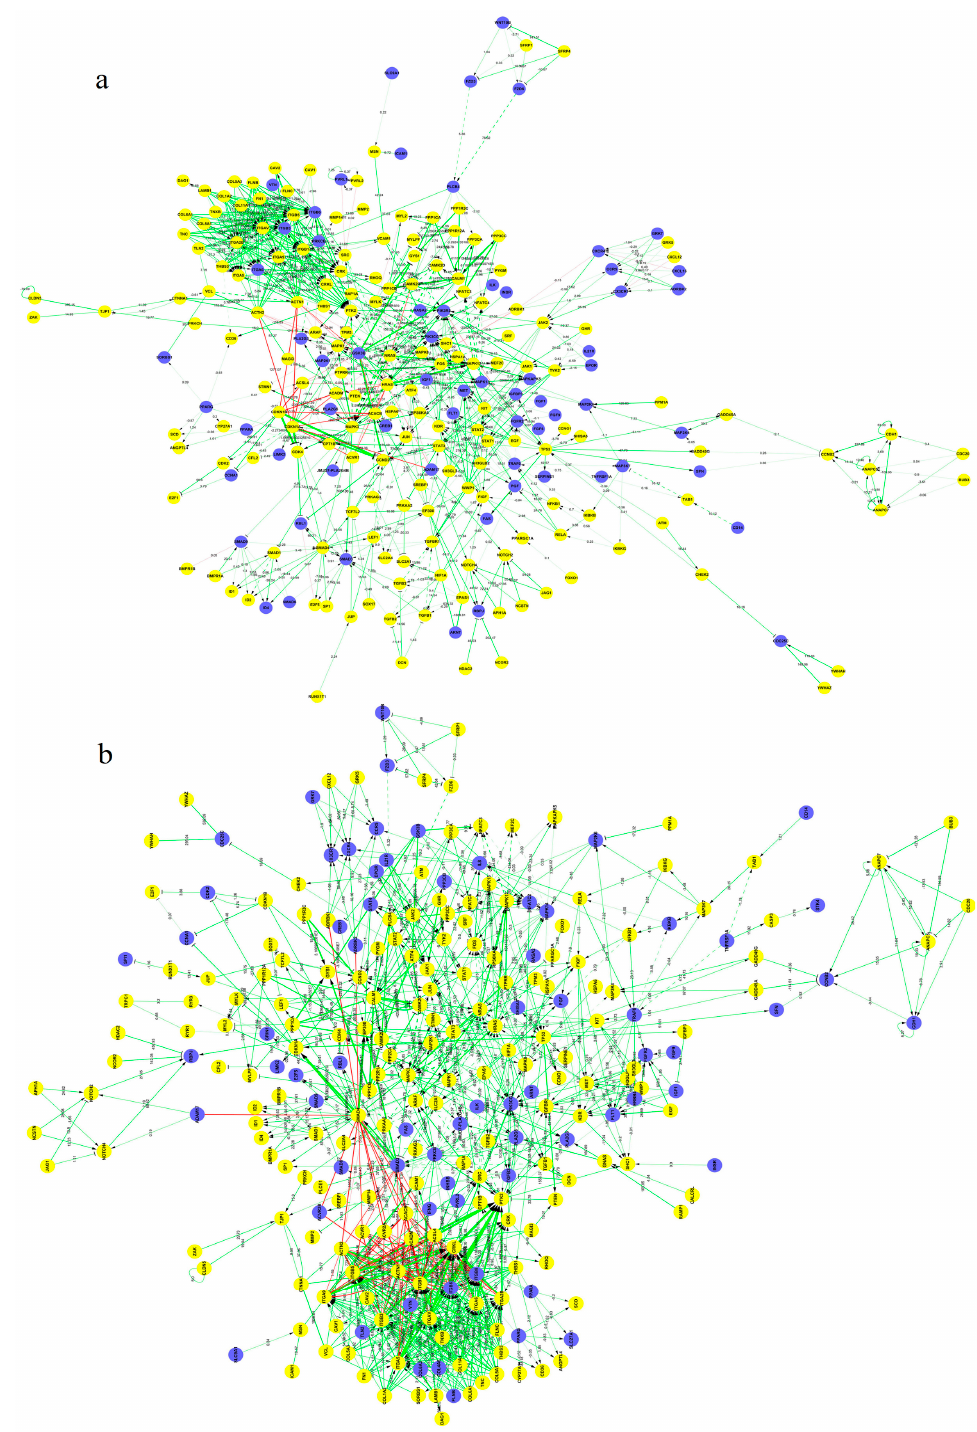
Figure 4. The interaction network of differentially expressed genes (DEGs) regulating myogenesis in Landrace (LR) ( a ) and Lantang (LT) ( b ) pig breeds. Yellow and blue dots represent DE and non-DE genes, respectively. Straight lines represent interaction association between genes. Solid and dashed lines represent direct and indirect interaction, respectively. Value and diameter of lines represent the interaction size [138].